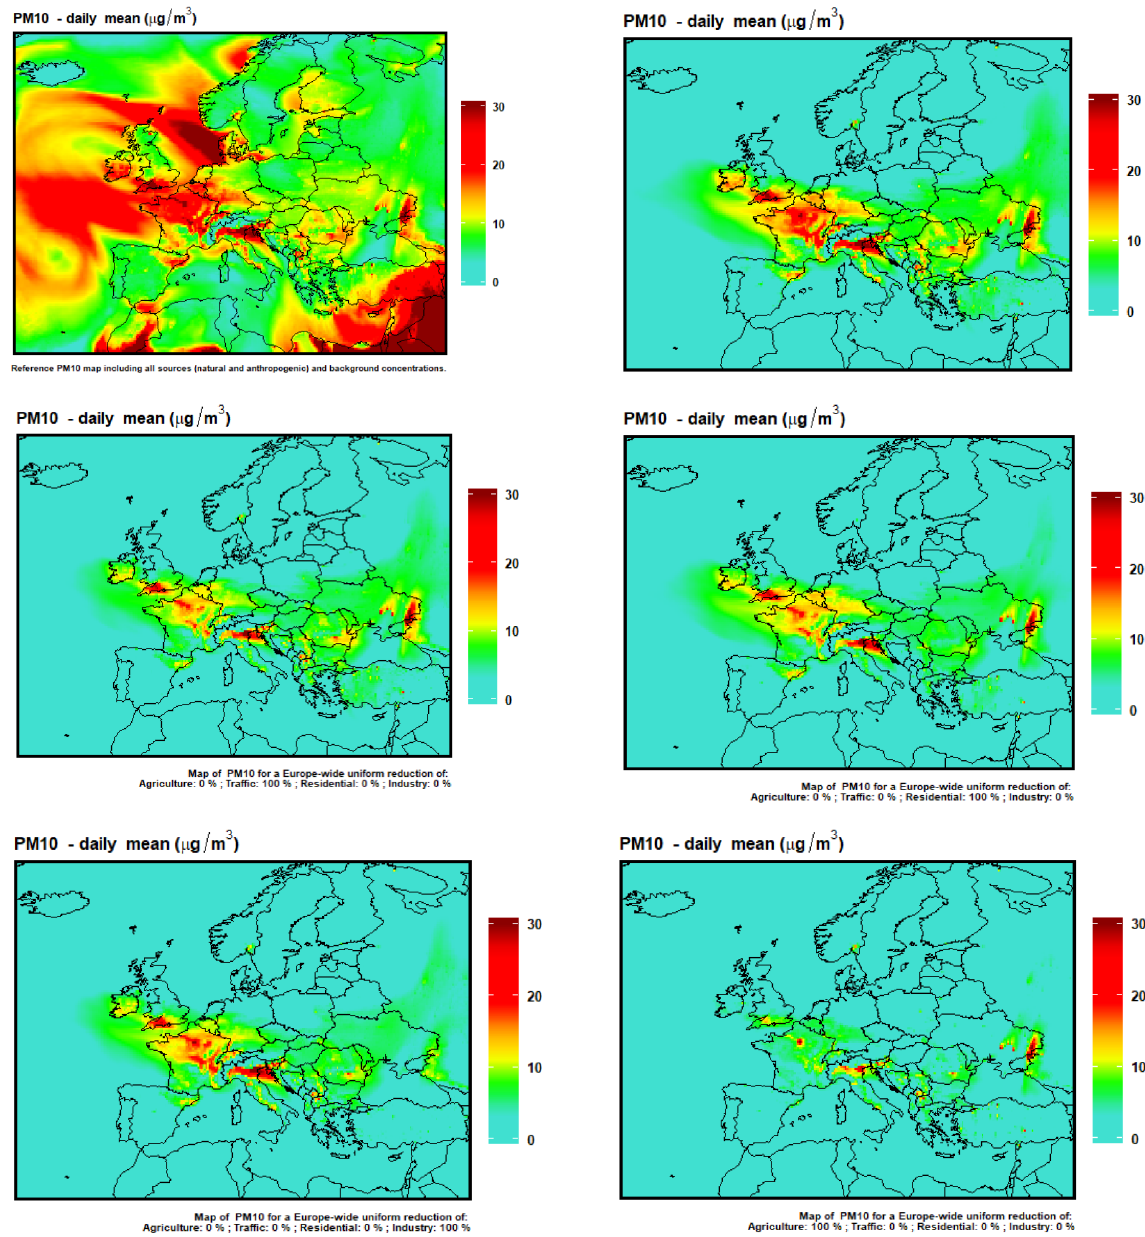
Figure 13. First row: PM 10 concentrations on 1 December 2016 including (left) or excluding (right) natural and background concentrations. Following rows: PM 10 daily average concentrations emulated with ACT for 1 December 2016 for a 100% reduction of traffic emissions (second row, left), residential emissions (second row, right), industry emissions (third row, left) and agriculture emissions (third row,